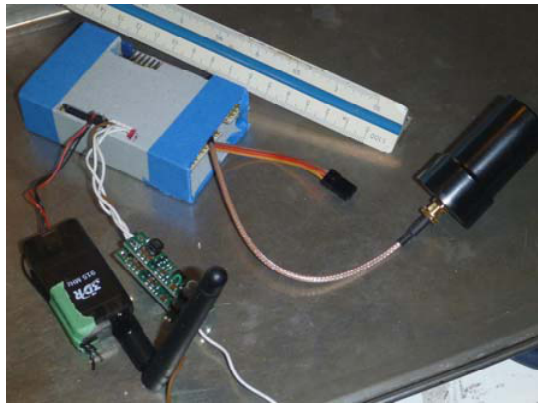
Figure 8. GNSS RTK rover for Study UAV. Dual frequency, GPS/GLONASS, synchronized camera event